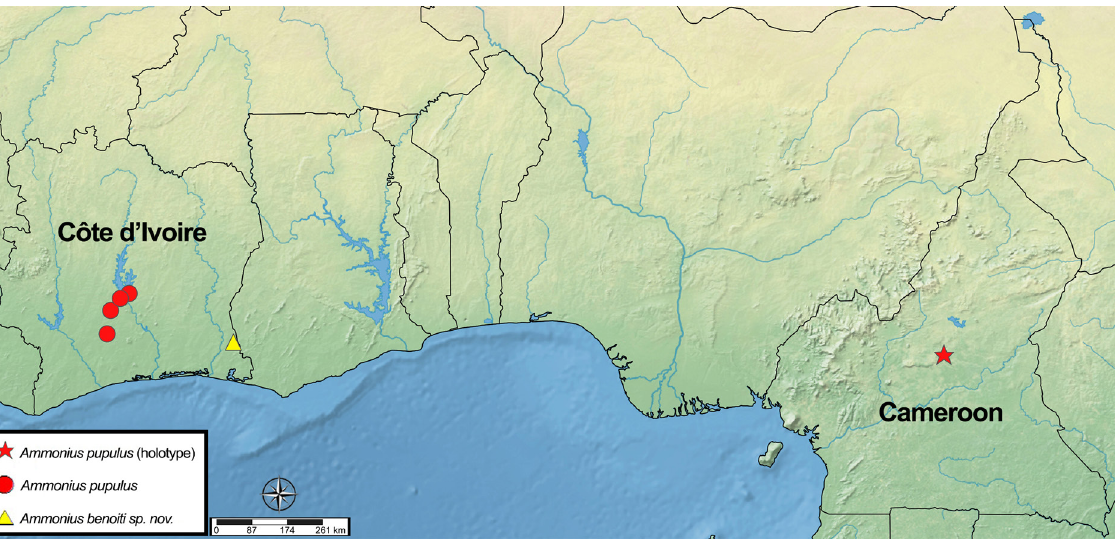
Fig. 10. Distribution map of the presently known species of the genus Ammonius Thorell,